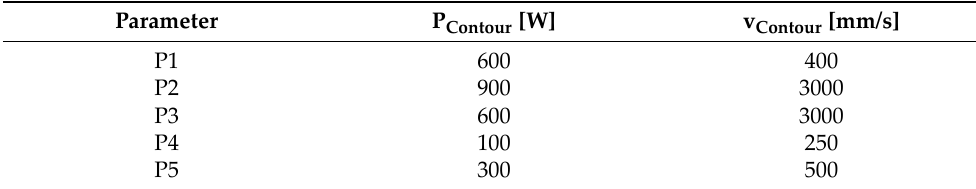
Table 2. Contour parameters for grooved wicks, with parameters P1 and P2 as contour parameters commonly used for bulk material with different surface roughnesses, and parameters P3, P4, and P5 adapted for printing filigree structures.